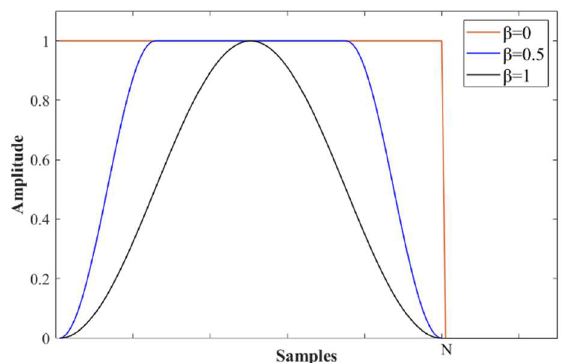
Figure 2. Shapes of Tukey window with various 𝛽 values.